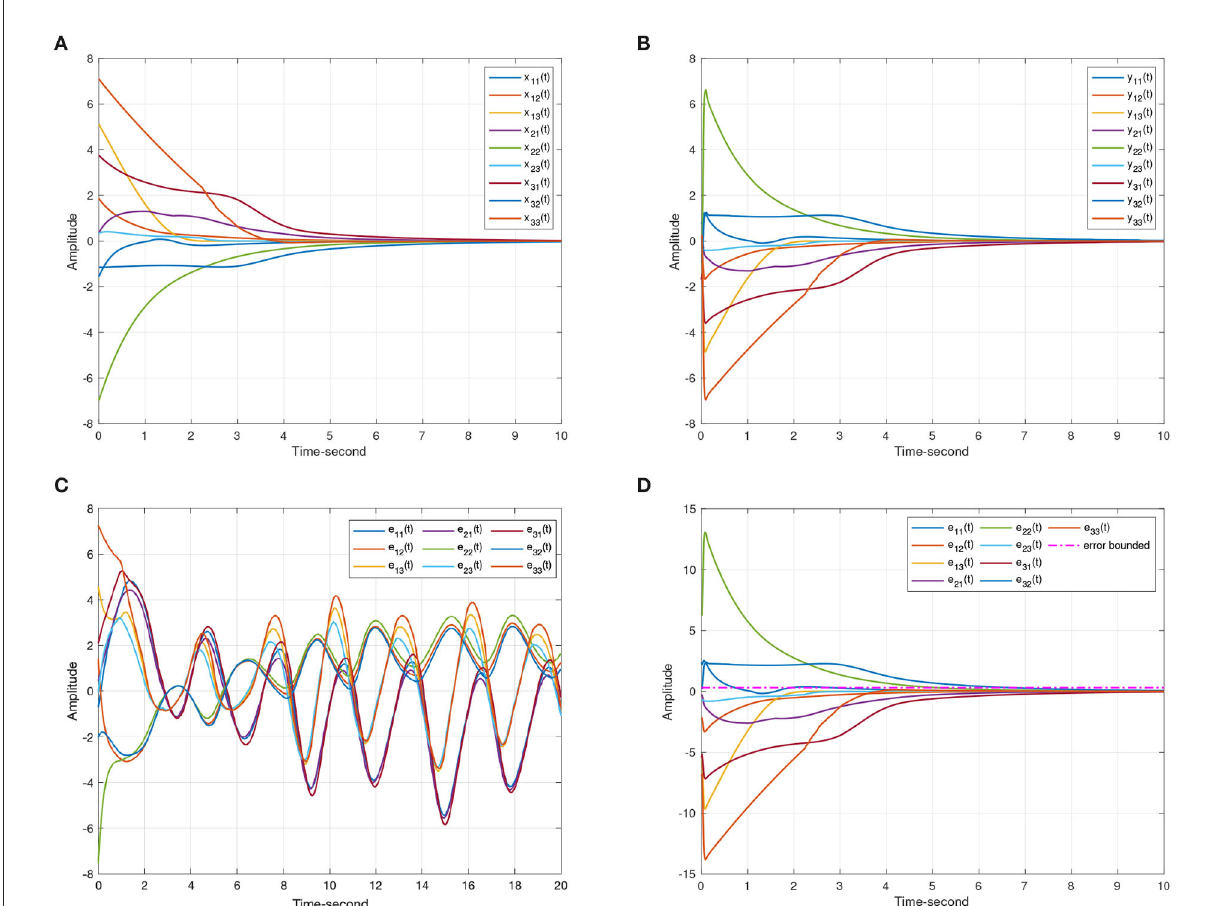
FIGURE6 The anti-synchronization state trajectories produced by systems (8) and (9). (A) The state curves of the drive system (8). (B) The state curves of the response system (9). (C) The anti-synchronization errors ε ( t ) event-triggered scheme